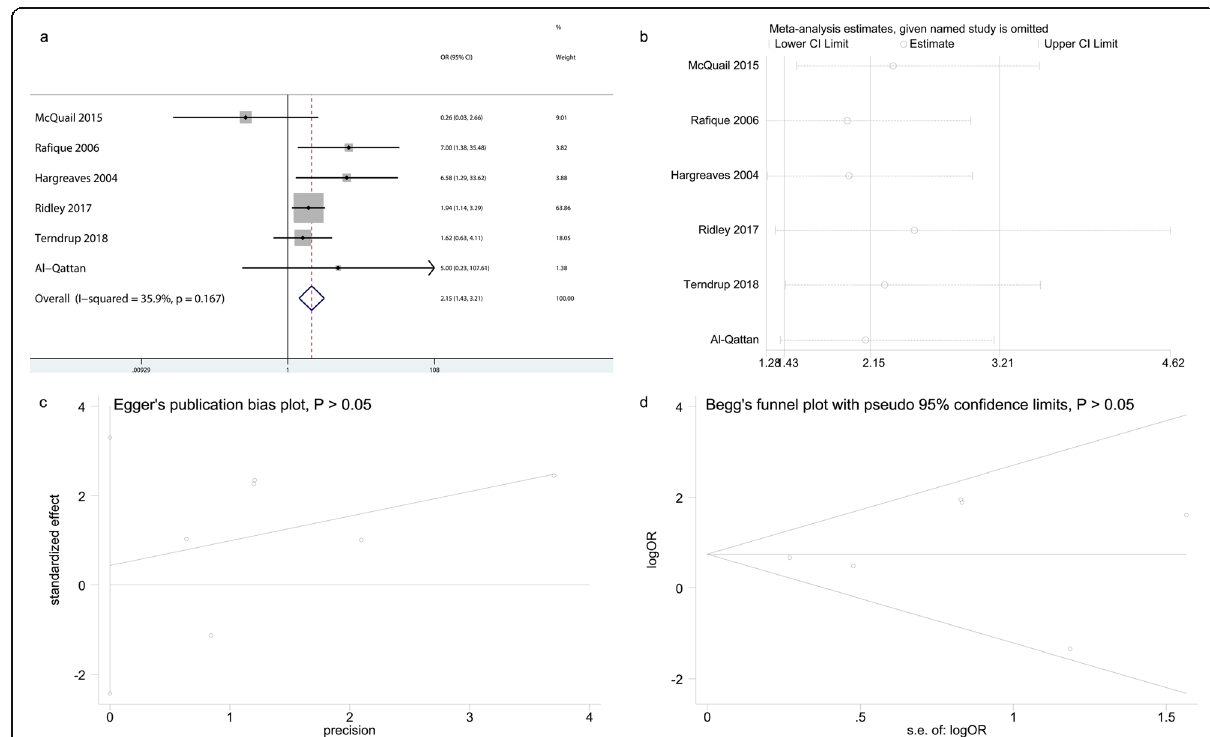
Fig. 3 The results of data synthesis for infection rate. a : Forest plot showing the infection rate comparing buried versus exposed Kirschner wire osteosynthesis for phalangeal, metacarpal and distal radial fractures; b : Sensitivity analyses for determining the reliability of results; c : Egger ’ s publication bias plot; d : Begg ’ s funnel